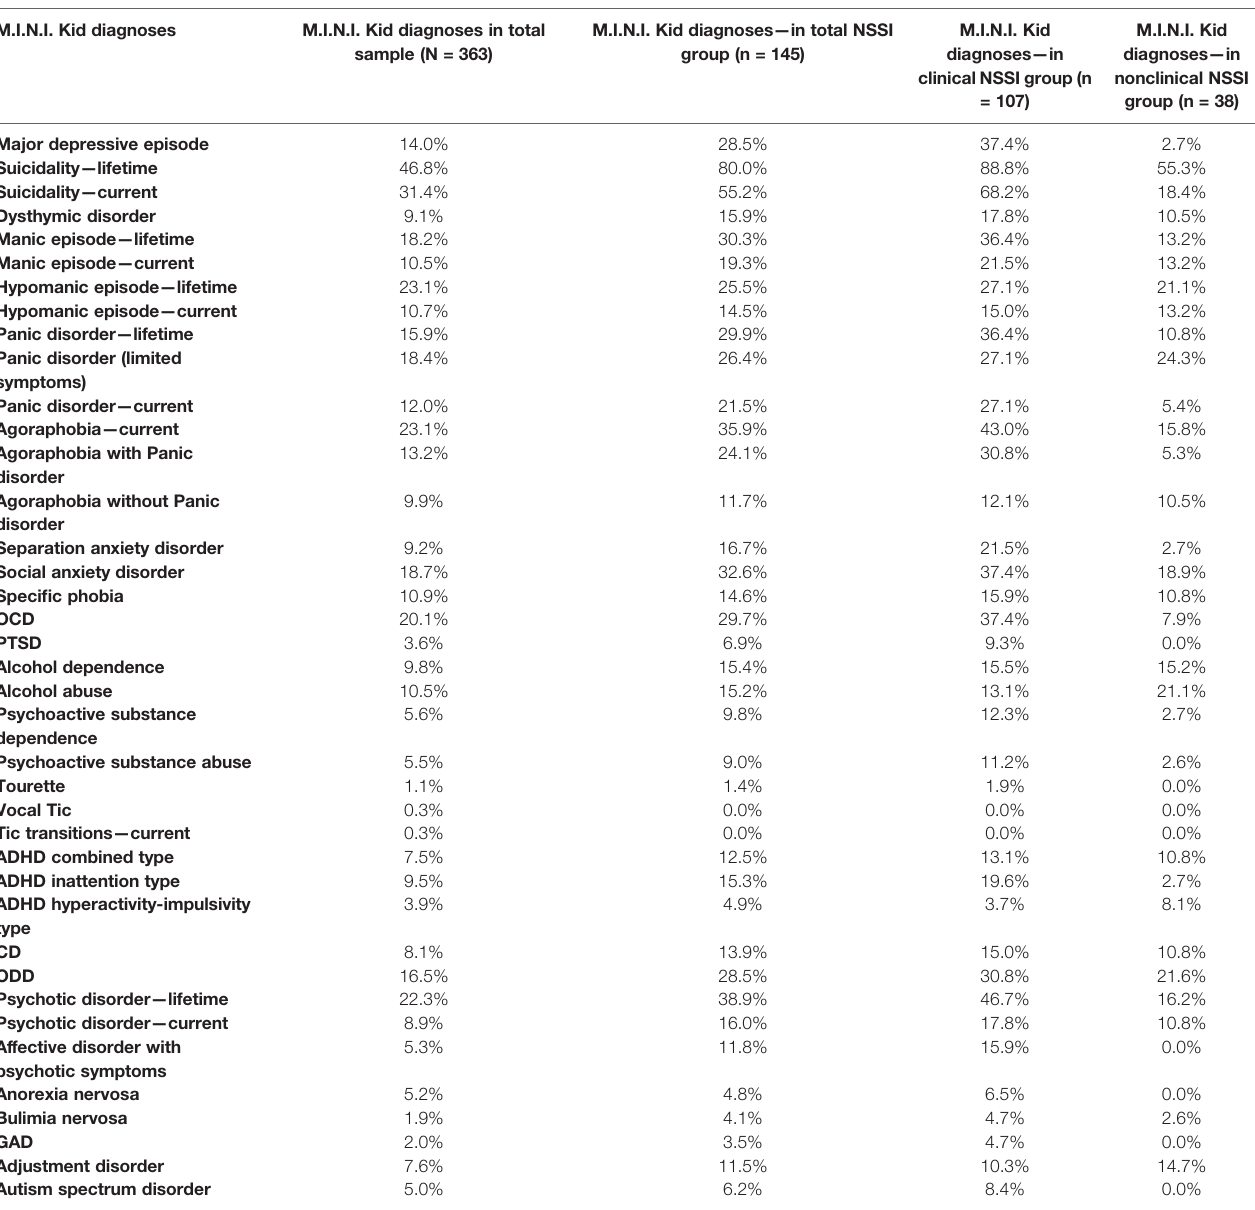
TABLE 1 | Prevalence of M.I.N.I Kid diagnoses.